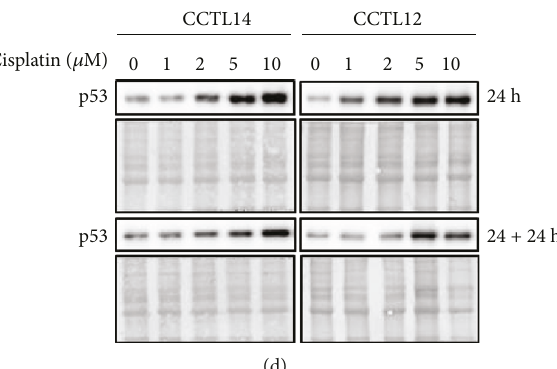
Figure 1: Cisplatin at concentrations of 1 μ M and 2 μ M induces DNA damage but not excessive apoptosis in hESC. Cells were treated with cisplatin at concentrations ranging from 1 μ M to10 μ M for 24 hours and then either harvested and fi xed (24 h) or further cultured in the absence of cisplatin for 24 hours (24 +24 h). (a) Morphology of nontreated and cisplatin-treated hESC as observed by light microscopy (10x, bar 50 μ m). Both CCTL12 and CCTL14 lines of hESC were used ( n = 1 for CCTL12; n = 3 for CCTL14); a representative picture is shown. (b) Graphs showing cell death incidence as determined by fl ow cytometric analysis after double staining with Annexin-V and propidium iodide. At least 10,000 cells were analyzed per sample. Living (Annexin-/PI-), apoptotic (Annexin+/PI-), necrotic (Annexin-/PI +), and secondary necrotic cells (Annexin+/PI+) are reported as a percentage of the total cell count. The CCTL14 line of hESC was used ( n = 2 ). (c) The presence of double-strand breaks in DNA as visualized by 53BP1 and γ H2AX foci using indirect immuno fl uorescence (40x, bar 20 μ m). Both CCTL12 and CCTL14 lines of hESC were used ( n = 2 ); a representative picture is shown. (d) The quantity of p53 protein in cisplatin-treated hESC as demonstrated by western blot analysis. A PVDF membrane stained with 0.1% amidoblack was used as a loading control. Both CCTL12 and CCTL14 lines of hESC were used ( n = 2